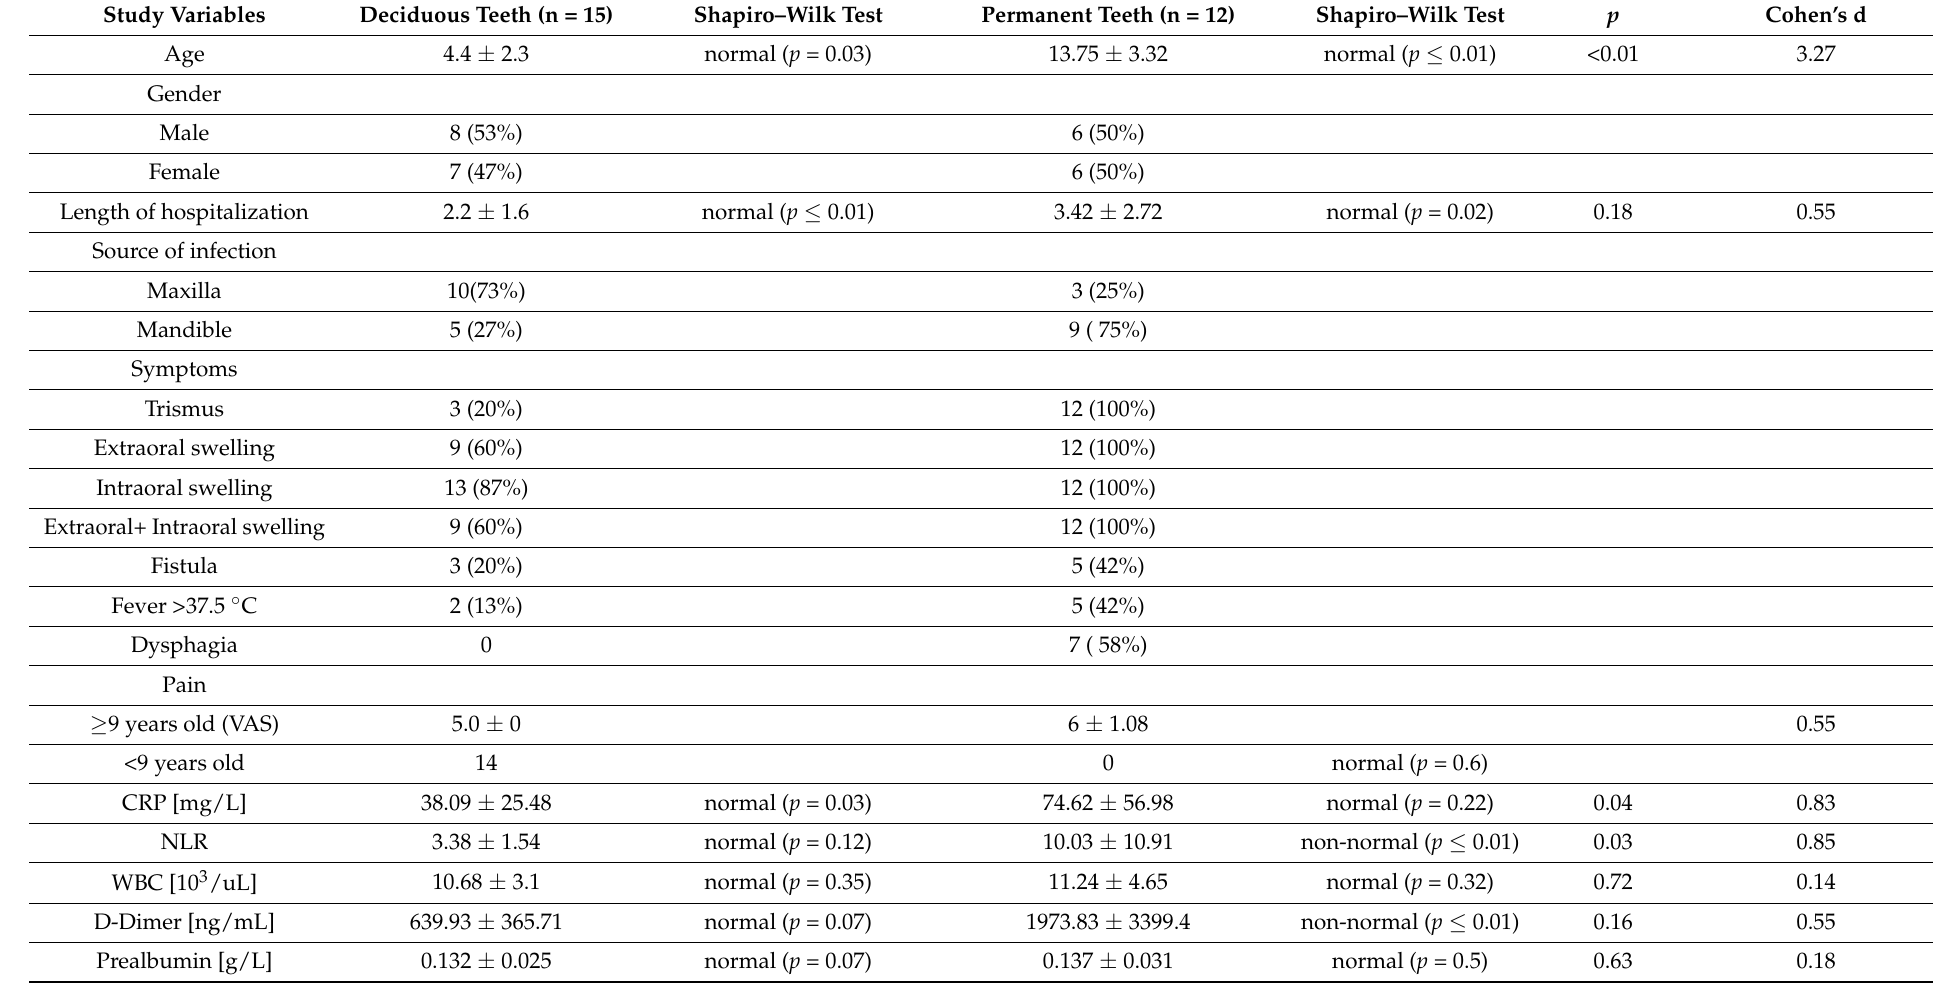
Table 2. Comparison of odontogenic infections of deciduous and permanent